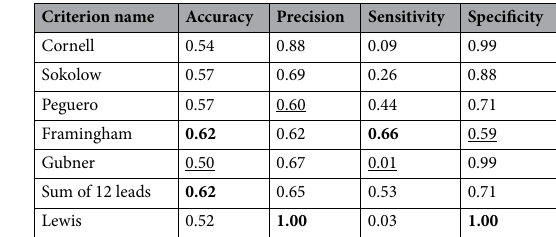
Table 3. Performances of 7 methods with different ECG criteria for assessing LVH. The bold and underlined values indicate the maximum and minimum